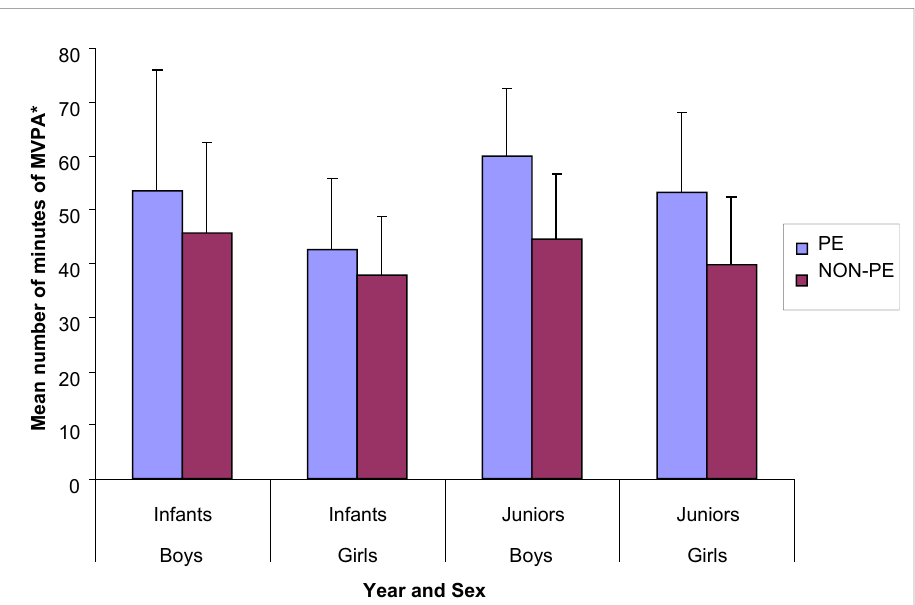
Figure 1. Children’s overall mean number of minutes ± SD of MVPA during PE and non-PE by year group and sex. * MVPA = moderate to vigorous physical activity levels. PE = Physical Education. Table 2. Different physical activity intensity levels during PE and non-PE days by age and